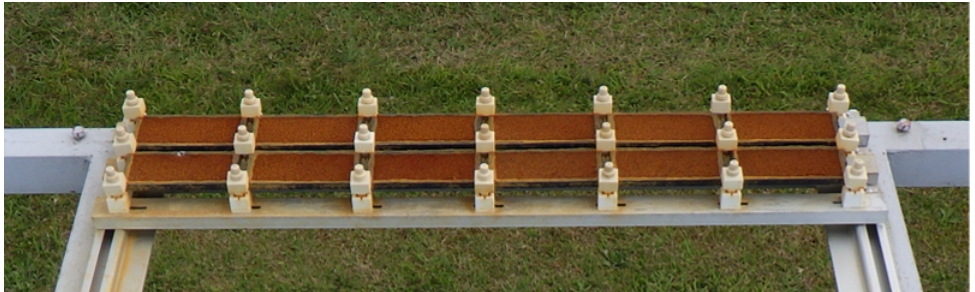
Figure 5. Atmospheric exposure